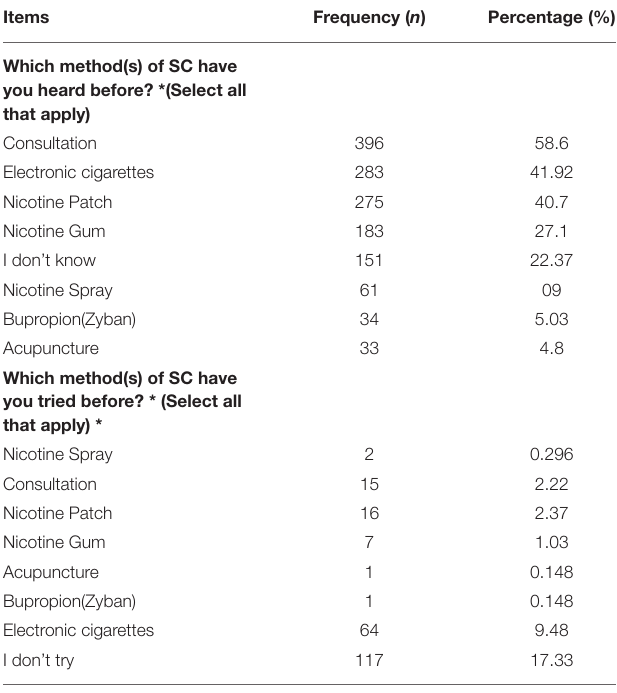
TABLE 2 | Student’s knowledge toward smoking cessation methods ( n = 675).